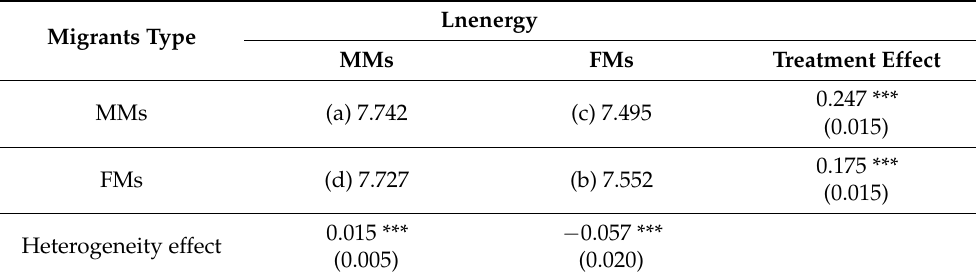
Table 5. Energy intake, treatment, and heterogeneity effects of migrants.